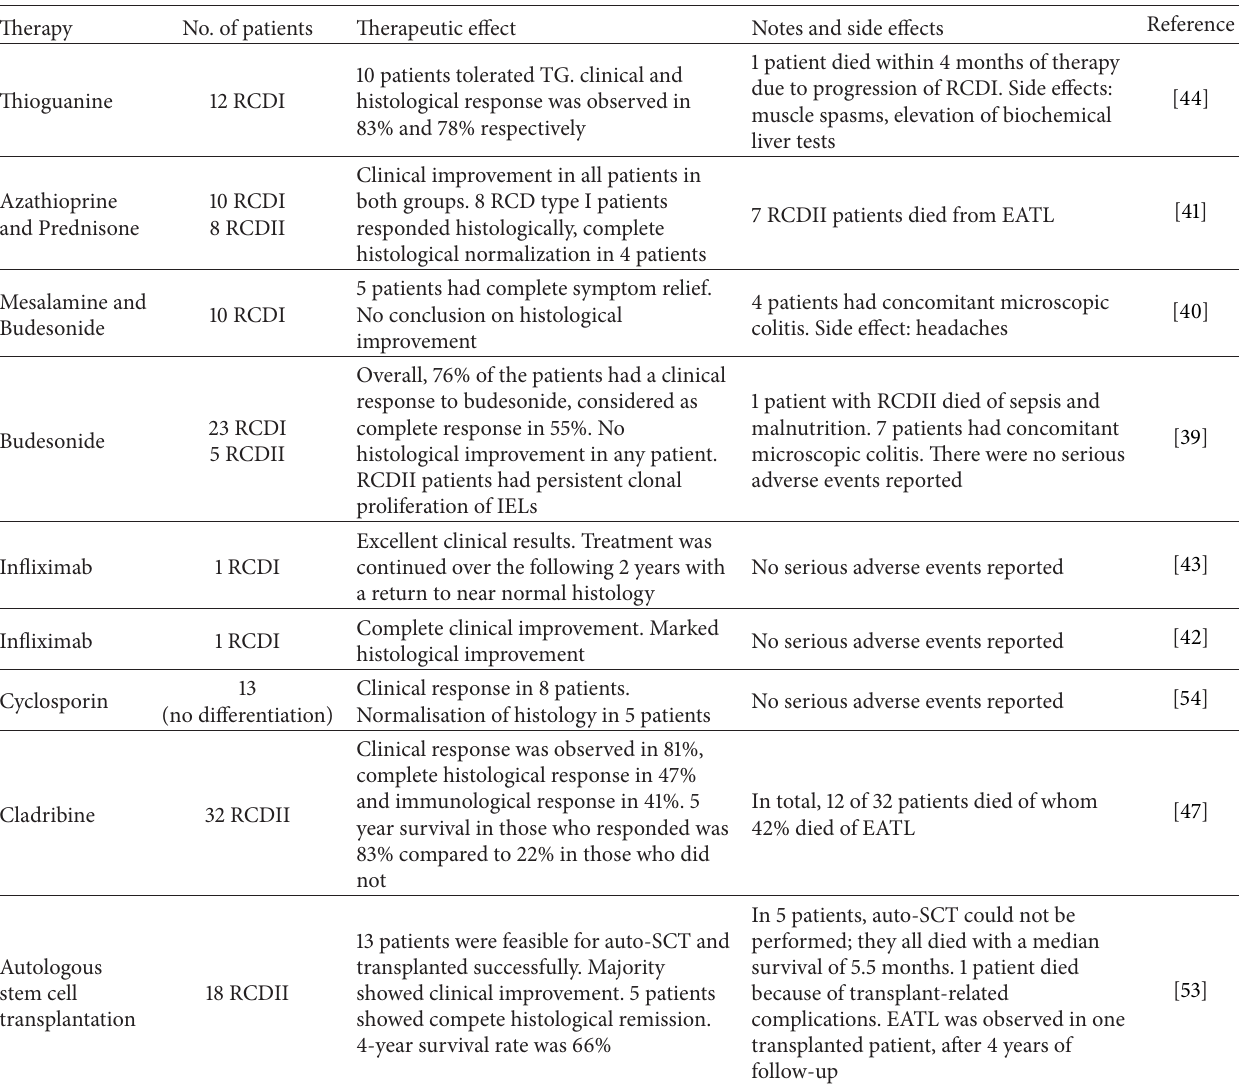
Table 1: Summary of treatment modalities evaluated in